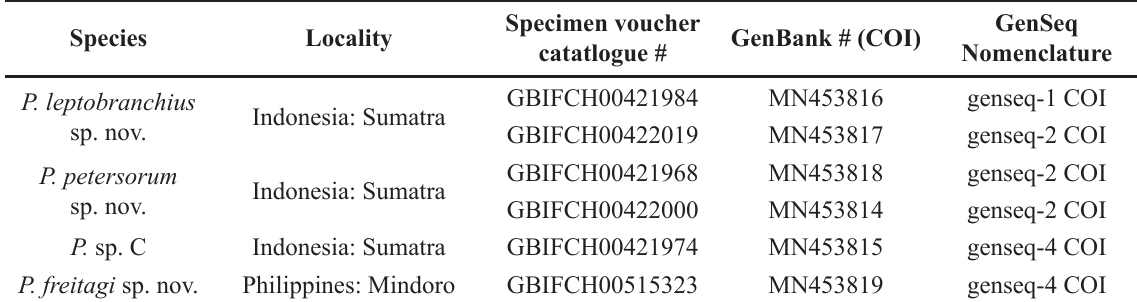
Table 1. Sequenced specimens of Procerobaetis gen. nov.